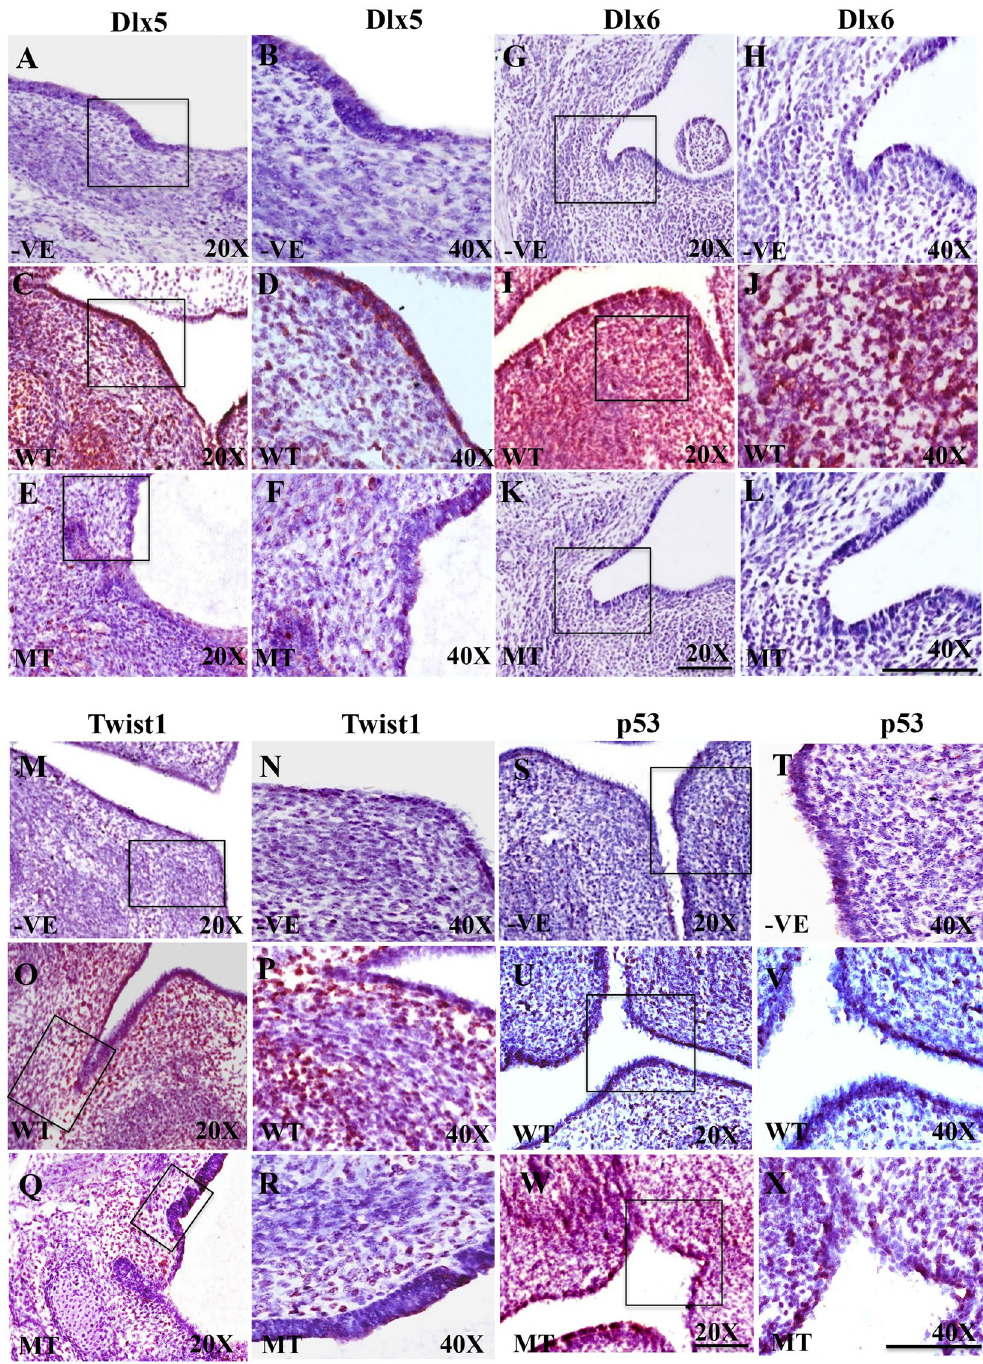
Figure 5. Protein expression of DLX5, DLX6, TWIST1 and P53 in mandibular tissues. The counter staining color used in the immunohistochemistry is purple for nuclei and protein expression is in red. Staining without primary antibodies was used as negative control ( A , B , G , H , M , N , S , T ). Expression intensity of DLX5 ( C , D ), DLX6 ( I , J ) and TWIST1 ( O , P ) in wild type tissues is reduced compared to double heterozygous mutant embryos for DLX5 ( E , F ), DLX6 ( K , L ), and TWIST1 ( Q , R ) in mandibular processes at E12.5. In contrary, expression of P53 is low in wild type ( U , V ), but increased in mutant ( W , X ) at E12.5. Scale bars = 20 μ